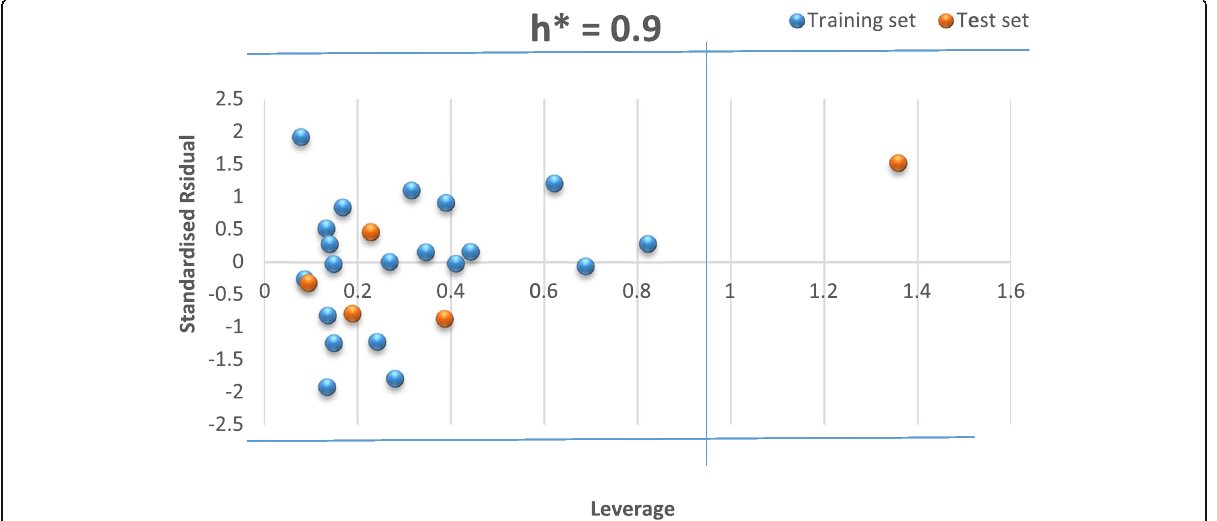
Fig. 5 The domain of applicability for outlier determination by William ’ s plot via plotting standardized residual against